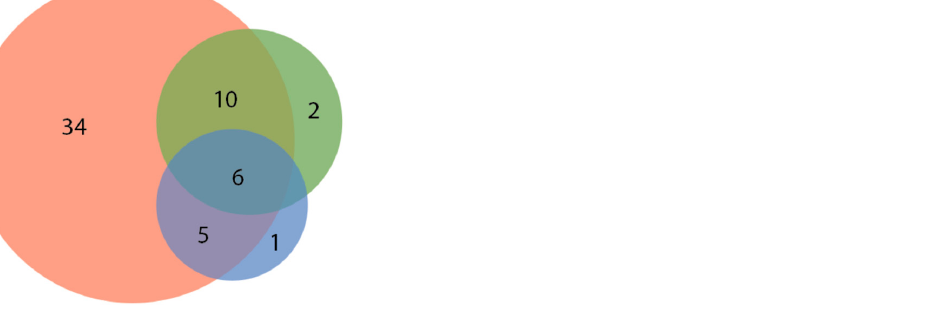
Figure 1. Preference of all tested fish species for laser pointer dot color, with 34 species preferring only red, 2 preferring only green, 1 preferring only blue, 10 preferring red and green, 5 preferring red and blue, and 6 preferring all three colors. No species appeared to only prefer blue and green. (All 8 species in “None” category not represented. See Table 1). Table 1. All species of fish tested, according to aquarium labels, by level of interest in laser pointer stimuli (irrespective of color preference). 8 of 66 showed no interest, 15 of 66 showed some interest, 28 of 66 showed moderate interest, and 15 of 66 showed high interest. REG = regular, SM = small, MD = Medium. * The Devario aequipinnatus was classified as having high interest in the laser stimuli but did not present with the same or similar behaviors as other fish in this category—rather than simply orienting towards or chasing after the stimuli, all Devario aequipinnatus would begin rapidly swimming and darting around their tank immediately upon presentation of the laser